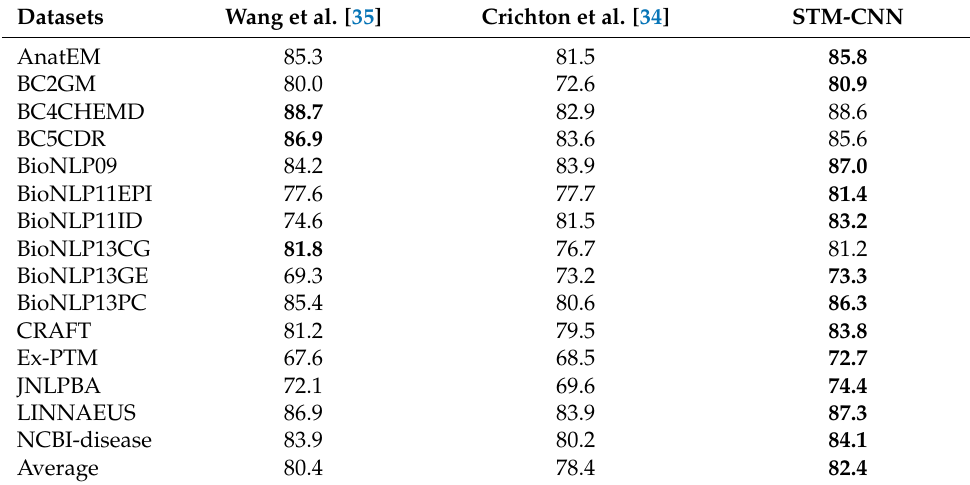
Table 2. Single-task model results comparison.